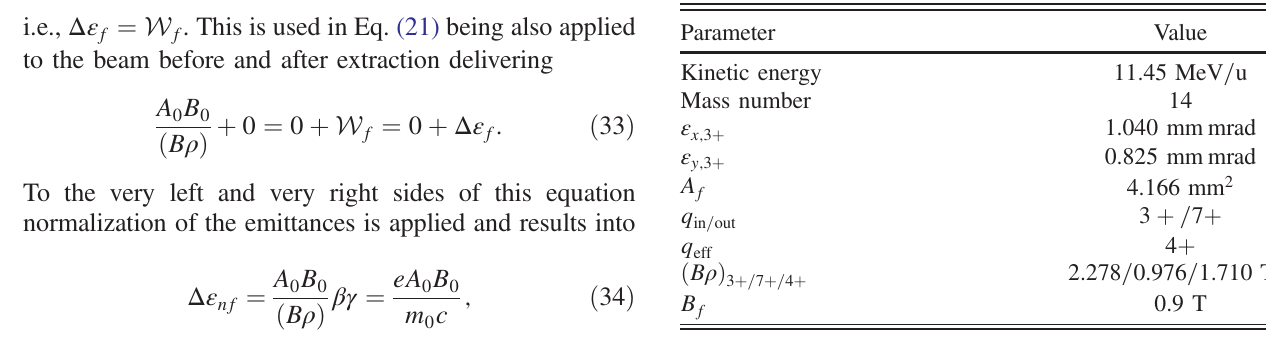
TABLE III. Beam parameters of the emittance transfer experi- ment EMTEX [20] in front of and behind the